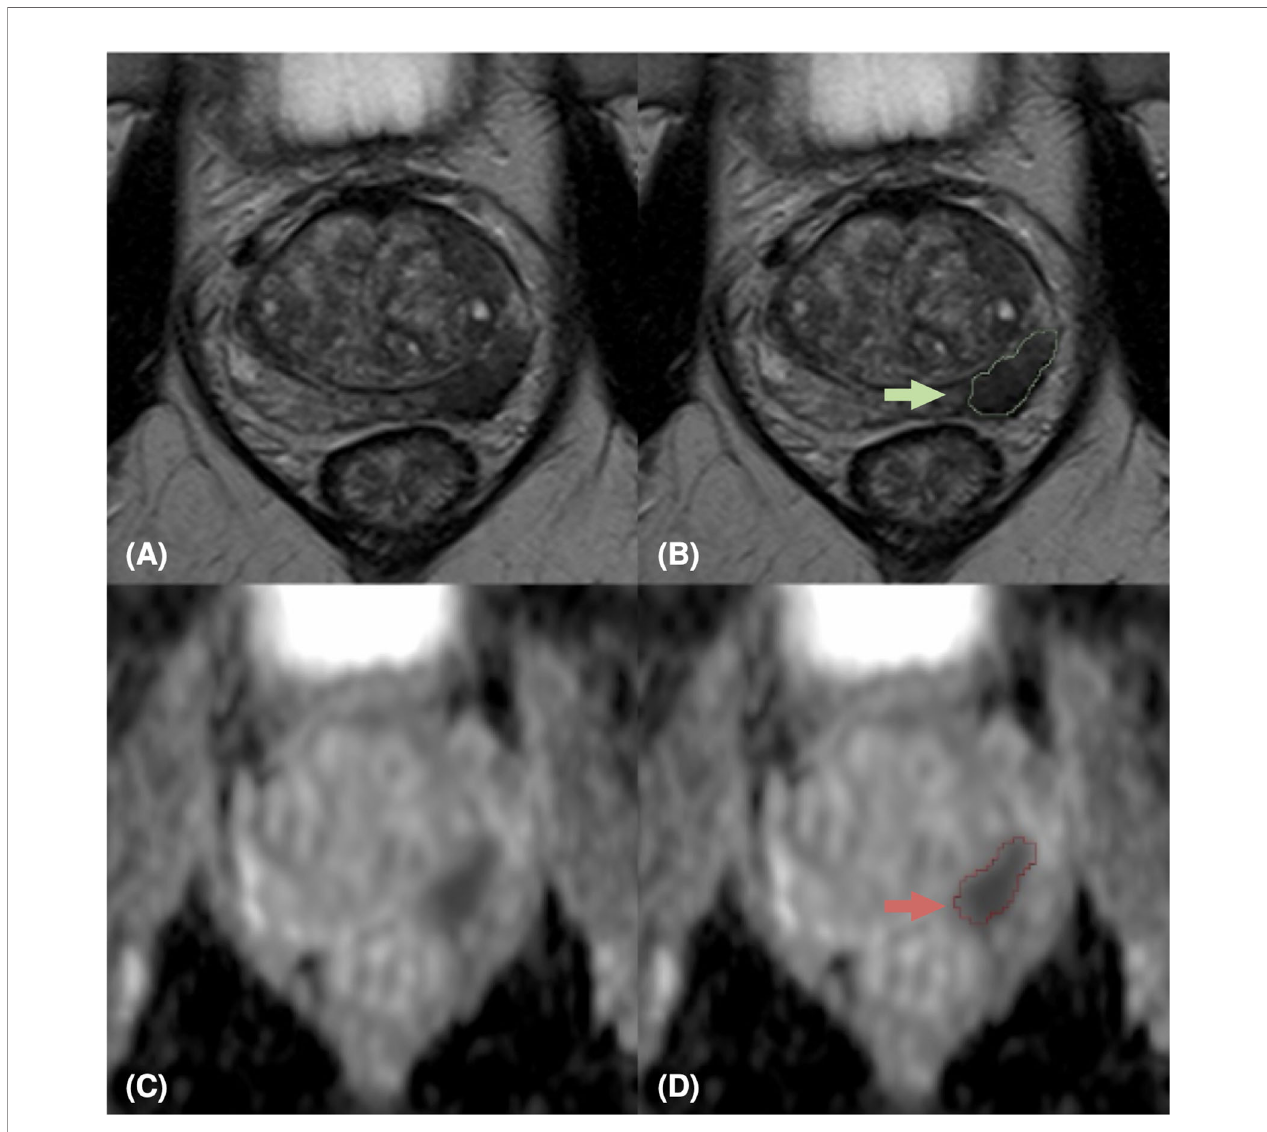
FIGURE 3 | MpMRI of a 69-years old patient with positive mpMRI result (PI-RADS=5), PSA level=7 ng/ml, GS=4+4 (ISUP 4). MRI zoomed images containing the target lesion, respectively axial T2-weighted image (A) , ADC map (C) , and their relative lesion segmentations (B, D) . The green (B) and red (D) arrows point out the segmented lesion in T2 and ADC images, respectively.